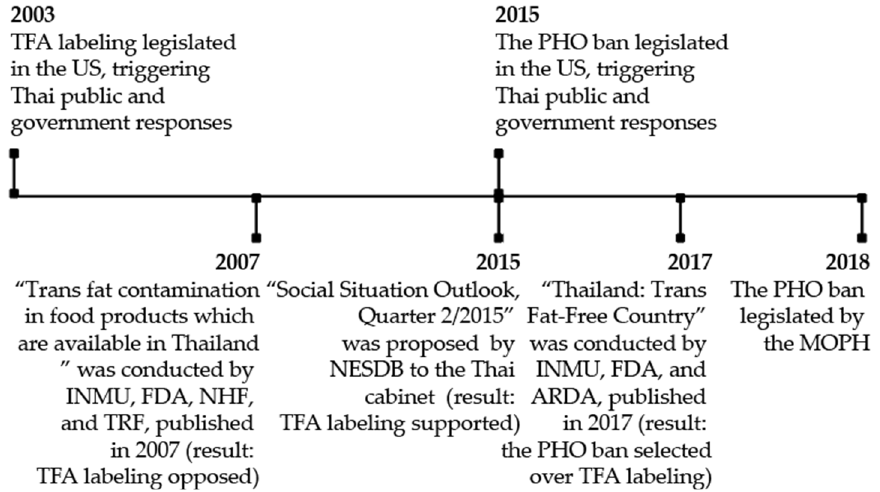
Figure 1. Timeline of TFA elimination policy decisions in Thailand.